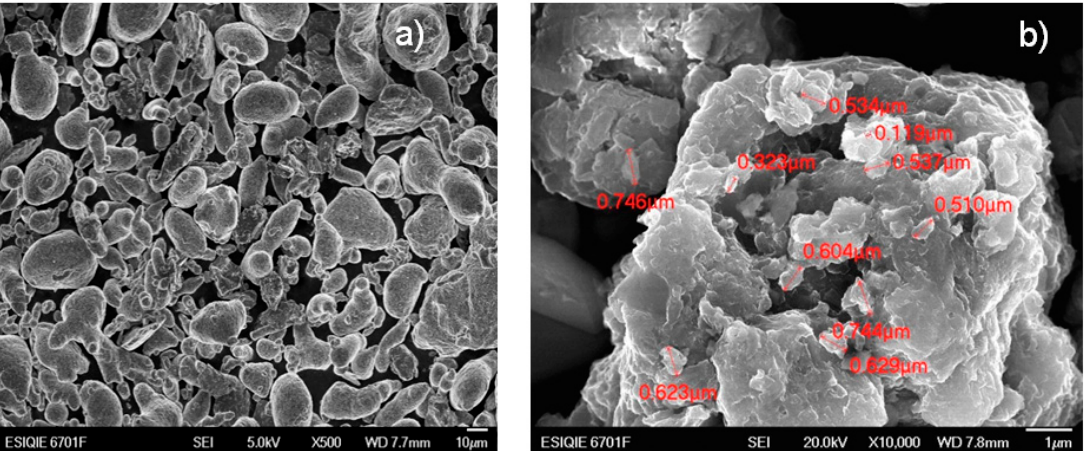
Figure 3. ( a ) The mixture of raw materials of Al, Ti and Fe powders and ( b ) Al, Ti and Fe powders after 300 h of milling.